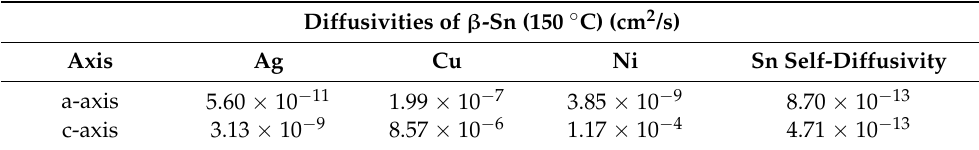
Table 1. Diffusivities of Ag, Cu, Ni, and Sn in the β -Sn matrix [49,53,54].